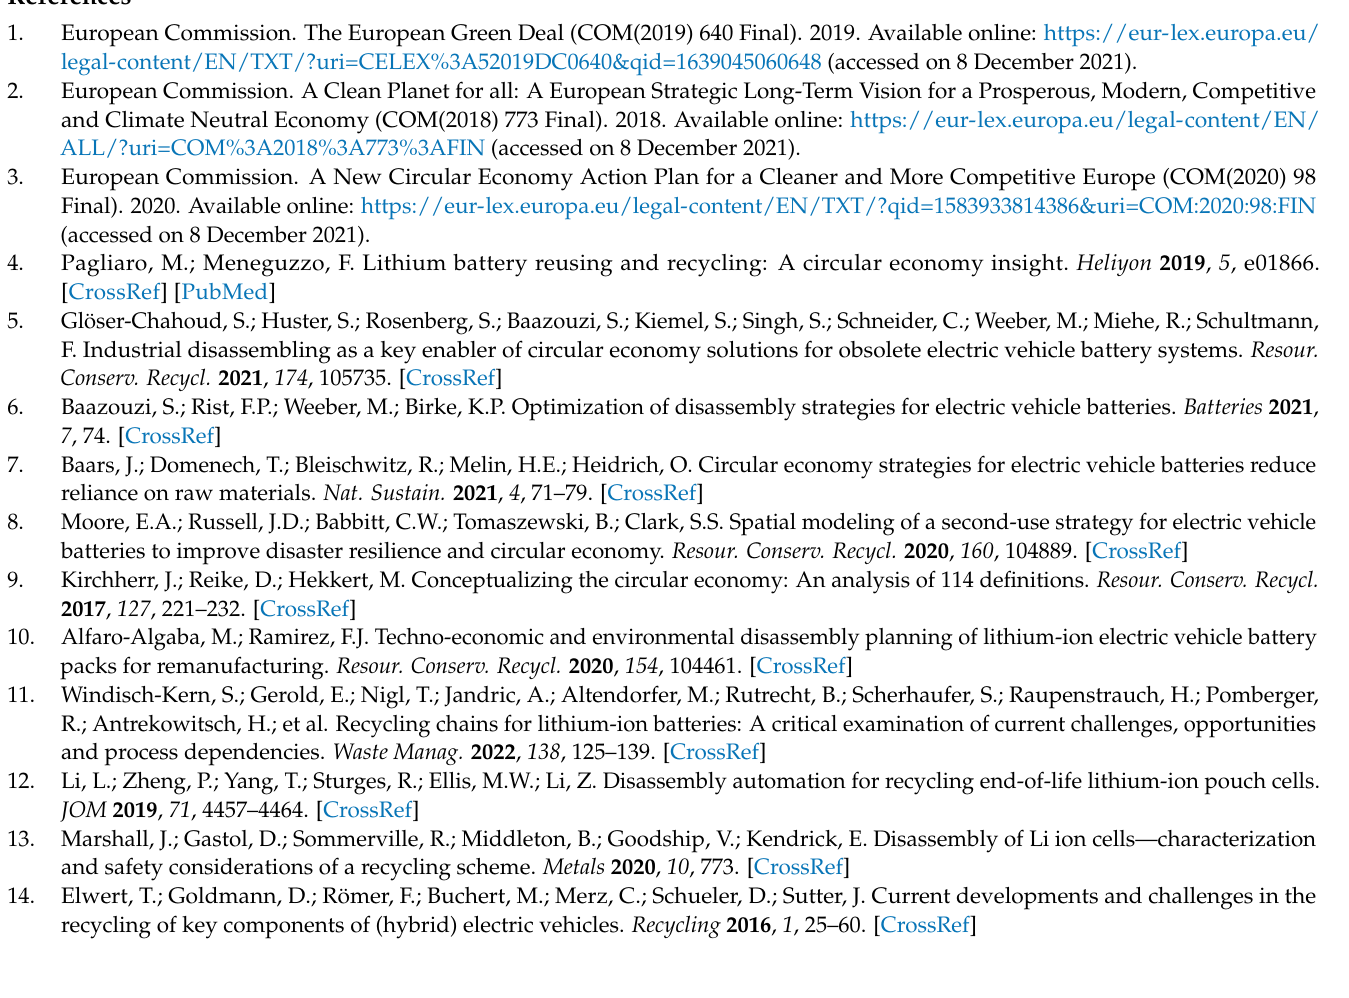
Figure A4. Scenario “Two Workers, cover together”: resulting fuzzy Gantt chart for each disassem- Figure A4. “ ” fuzzy Gantt chart for each disassem- ) and fuzzy finish time ( (cid:101) t f ) bling step and calculated fuzzy start time ( (cid:101) t s bling step and calculated fuzzy start time ( 𝑡 ̃ 𝑗𝑠 ) and fuzzy finish time ( 𝑡 ̃ 𝑗𝑓 ) . j j